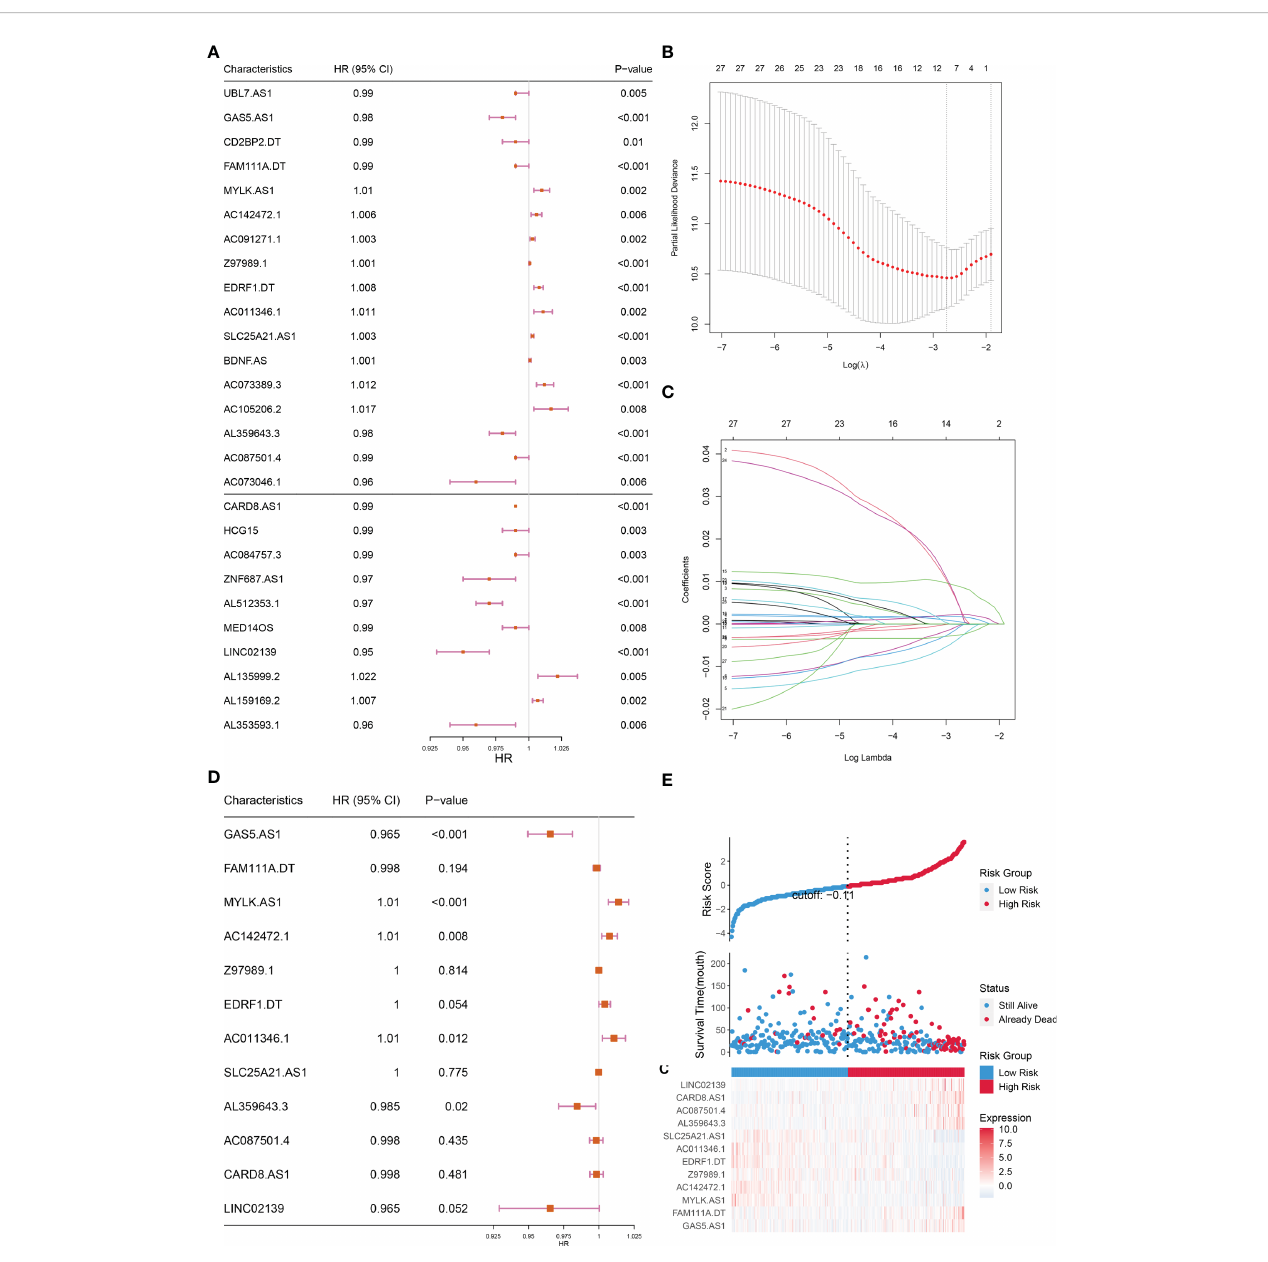
FIGURE 3 Construction of the prognostic cuproptosis-related lncRNAs signature for in the training set. (A) Based on univariate Cox regression analysis, 21 of the 71 cuproptosis-related lncRNAs were screened, as shown by the forest map. (B, C) Lasso regression analysis was used to further screen out 12 lncRNAs based on 10-fold cross-validation. (D) Forest plot of 12 cuproptosis-related lncRNAs based on Multivariate Cox regression. (E) The riskscore distribution, OS, and the Heat map of fi ve lncRNAs of patients in the training